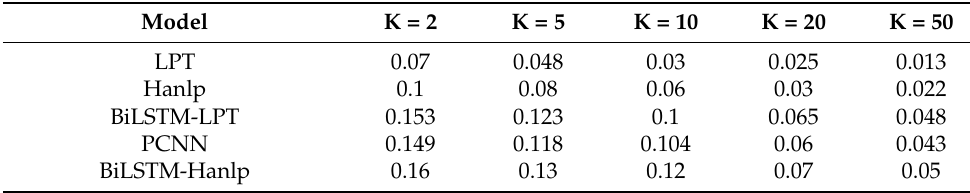
Table 10. Experimental results of